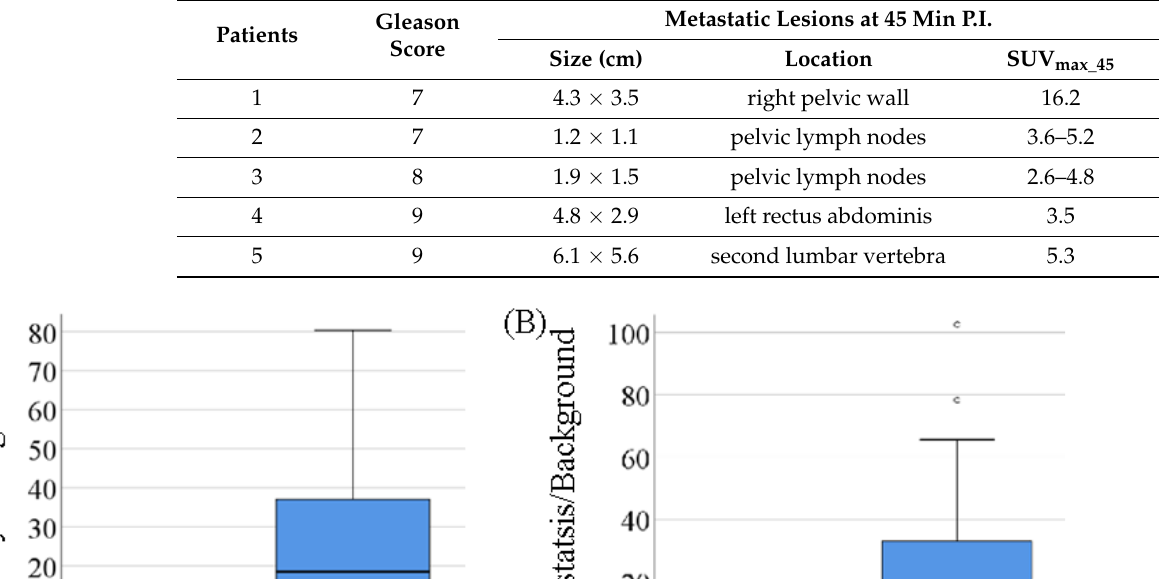
Table 2. The characteristics of five subjects that presented missed metastatic lesions in 3 min P.I.